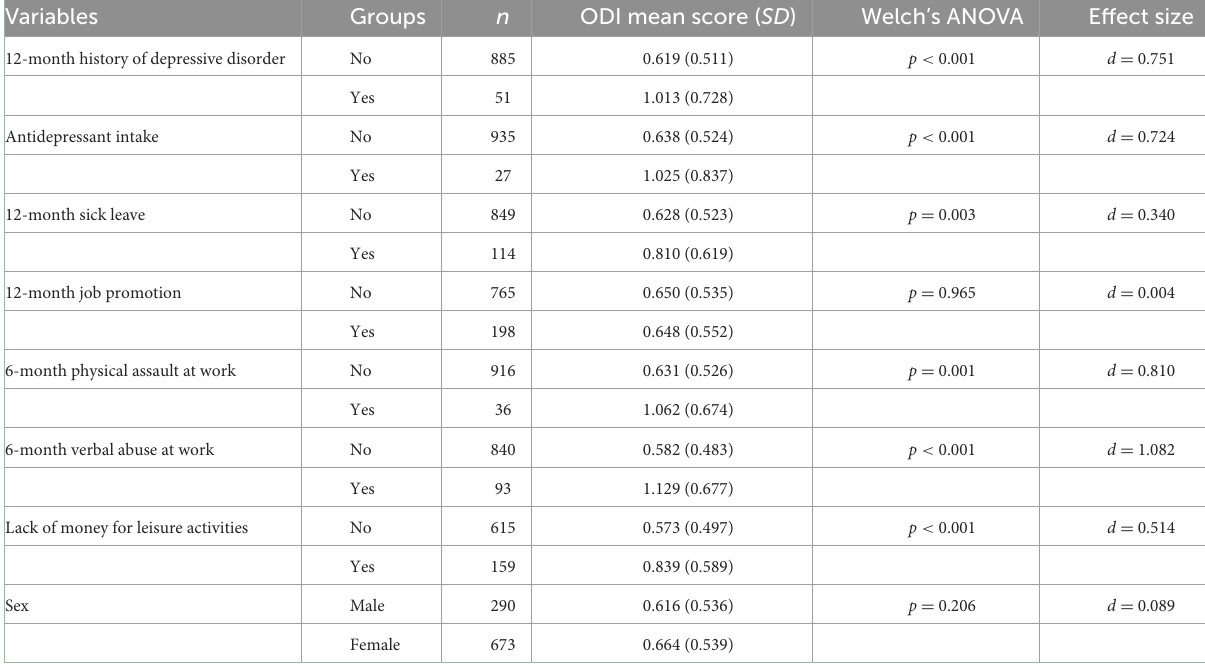
TABLE 4 Robust tests of equality of means.